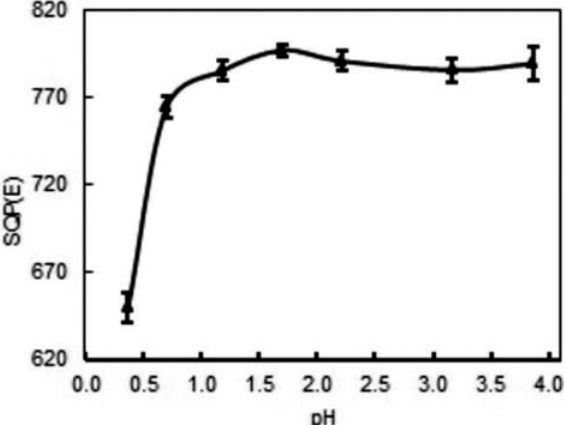
Figure 3. The SQP(E) variations as a function of pH for deionized water